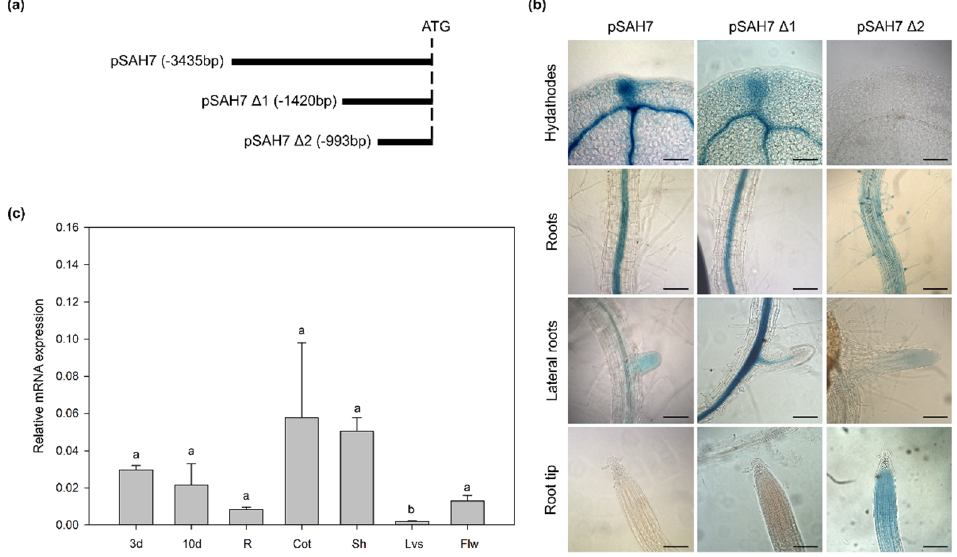
Figure 1. Promoter analysis and expression of At SAH7 in different developmental stages. ( a ) Schematic presentation of pSAH7 deletions. ( b ) Promoter analysis of At SAH7 in 6-day-old seedlings. pSAH7 fragments were transcriptionally fused to the GUS reporter gene and displayed different expression patterns. Bar 100 μ m. ( c ) Relative expression analysis of At SAH7 in different developmental stages. Tissues examined: 3d: 3-day-old seedlings; 10d: 10-day-old seedlings; R: root; Cot: cotyledons; Sh: Shoots; Lvs: rosette leaves and Flw: flowers. Values ± SD were normalized to the mean of UBQ10 and represent the mean of three biological samples analyzed in triplicate. Significant differences at p ≤ 0.05 are indicated by letters a,b.